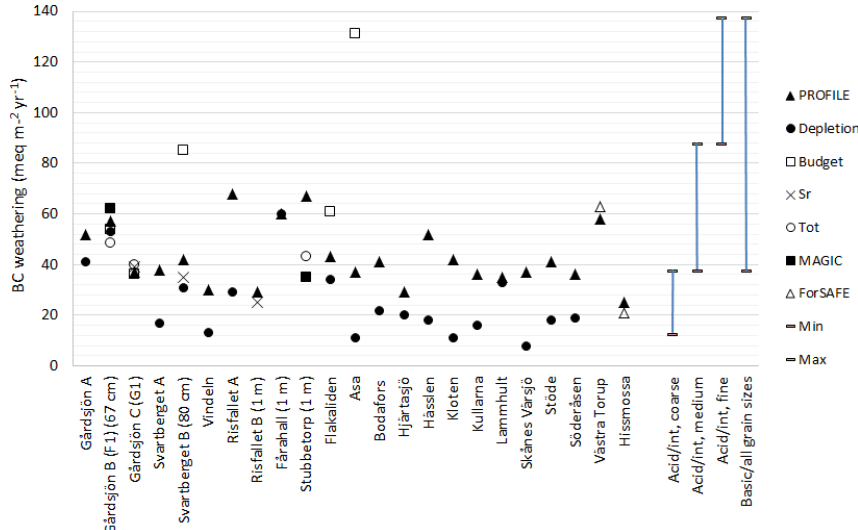
Figure 3. Base cation weathering rates (sum of Ca, Mg, Na and K) for sites where different methods have been applied for the same depth on the same site (Fig. 2). The soil depth is around 0.50m (with or without organic layer; see Table 1), except for a few cases where greater depths are given. The four spans to the right are intervals that were commonly used in the critical load work of CCE (Coordination Centre for Effects) within the UNECE Convention on Long-range Transboundary Air Pollution (LRTAP convention) (de Vries, 1994; Umweltsbundesamt, 1996). The intervals correspond to weathering rates for different parent material classes – acidic, intermediate and mafic – and different texture classes – coarse, medium (including the mix between medium and course material) and fine (including the mix between fine and medium